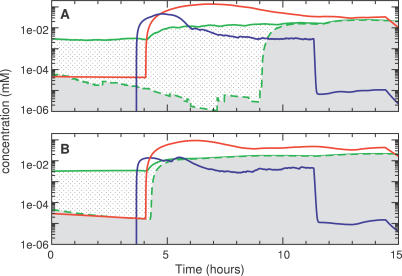
Dynamics of Two Promoter Functions(A) The stochastic model: red indicates external lactose concentration; blue, external glucose concentration; and green, the β-galactosidase concentration (which is converted to mM to compare it with the deterministic model, a concentration of 2e-06 mM corresponds with 1 molecule per cell, just after cell division). The solid line indicates the β-galactosidase concentration for the promoter function with the high repressed transcription rate, while the dashed line corresponds to the promoter function with the low repressed transcription rate.(B) Same as (A), for the deterministic model. Note that, because cells behave differently in each model, the extracellular glucose and lactose concentrations are not identical (but very similar) in both (A) and (B).